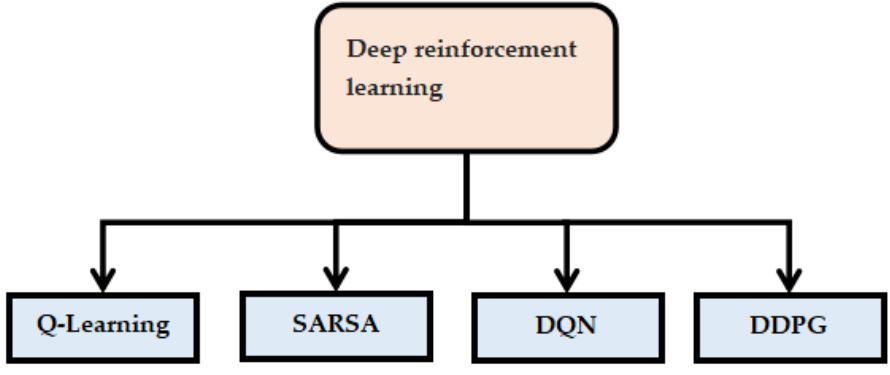
Figure 9. Deep reinforcement learning [92].